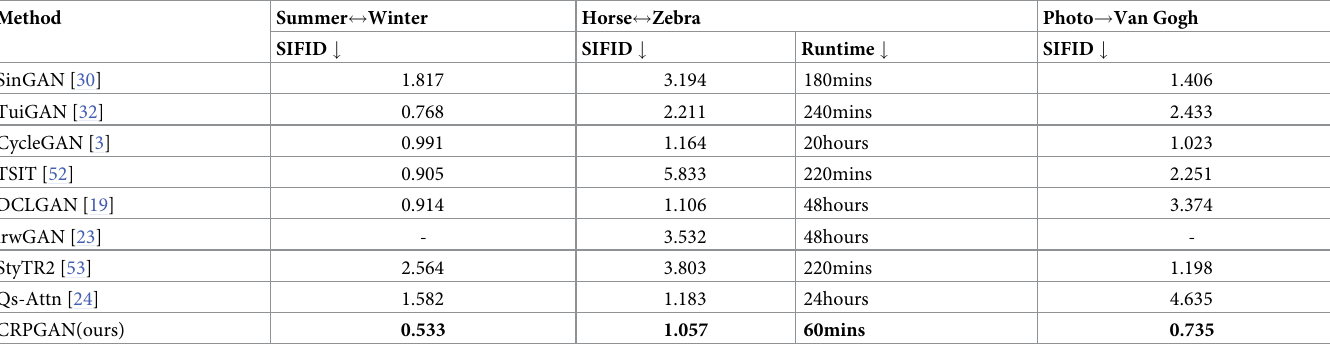
Table 2. Average SIFID and training time of various baselines versus our method on general UI2I tasks.